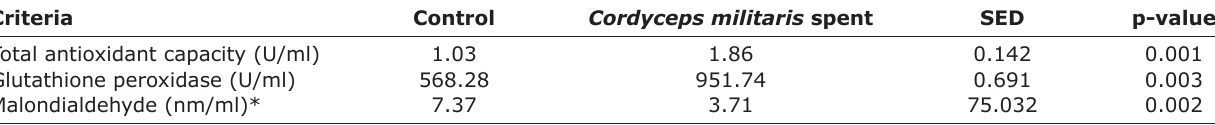
Table-6: Antioxidant capacity in growing pigs fed Cordyceps militaris spent mushroom substrate 1 .